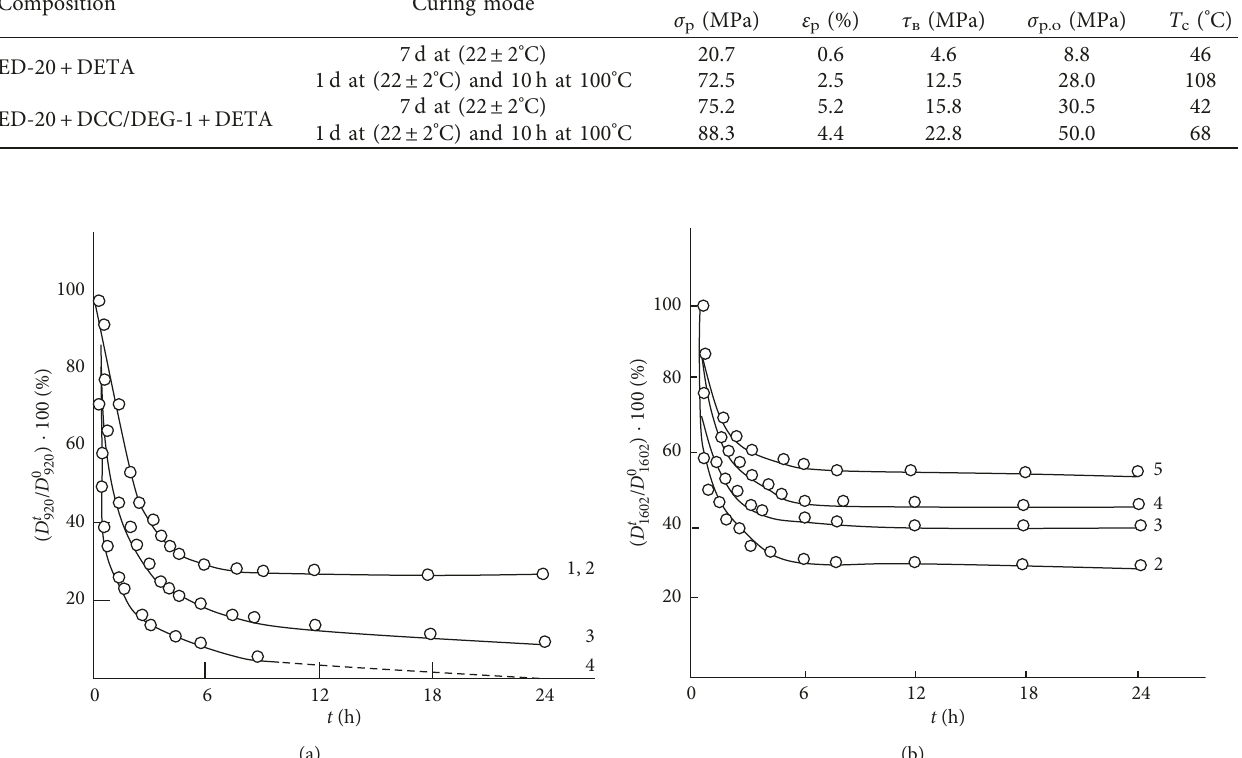
Table 3: Physicomechanical properties of polymers obtained under different conditions of curing epoxy-amine compositions. Composition